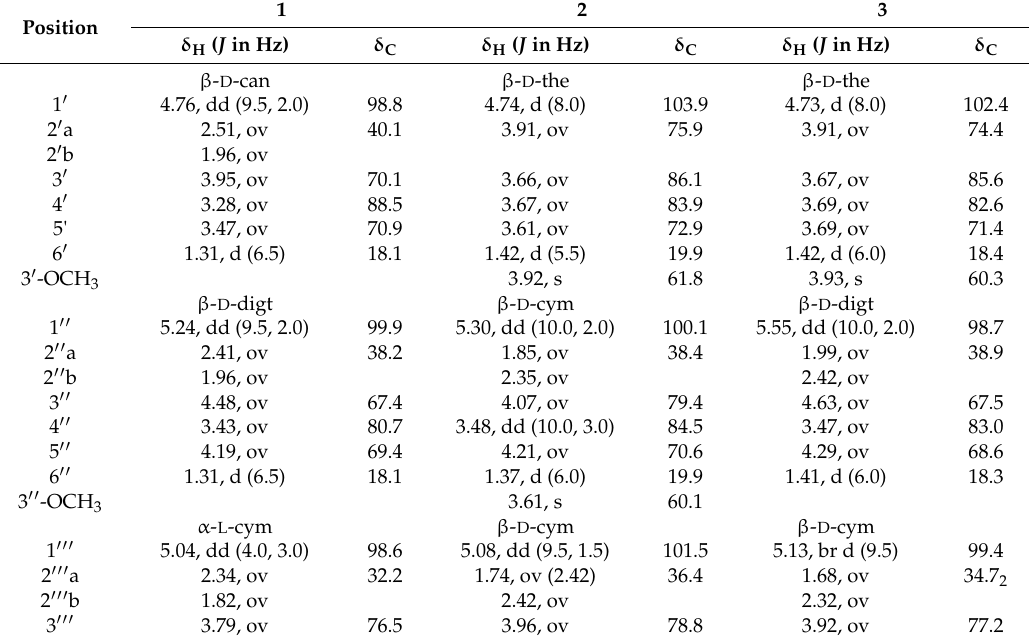
Table 2. 1 H- and 13 C-NMR spectroscopic data for the sugar moieties of 1 – 3 (pyridine- d 5 ).